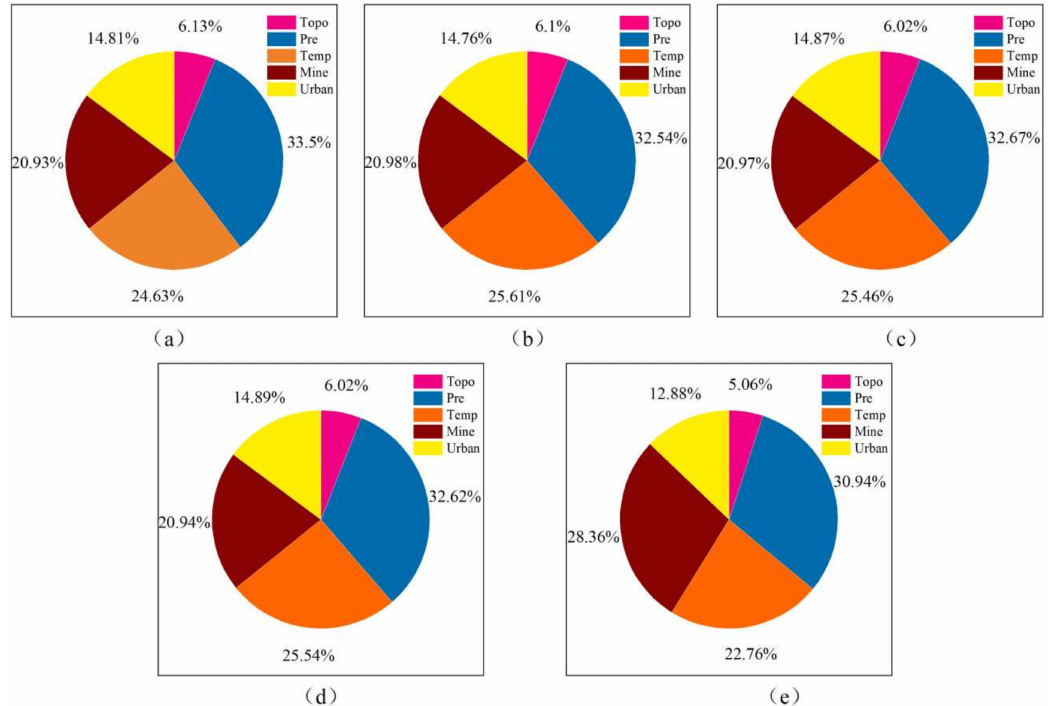
Figure 12. The pie chart of driving factor contribution in different directions. ( a – e ): Directions 1–5. Topo represents the factor of topography; Pre represents the factor of precipitation; Temp represents the factor of temperature; Mine represents the factor of mining, and Urban represents the factor of urban